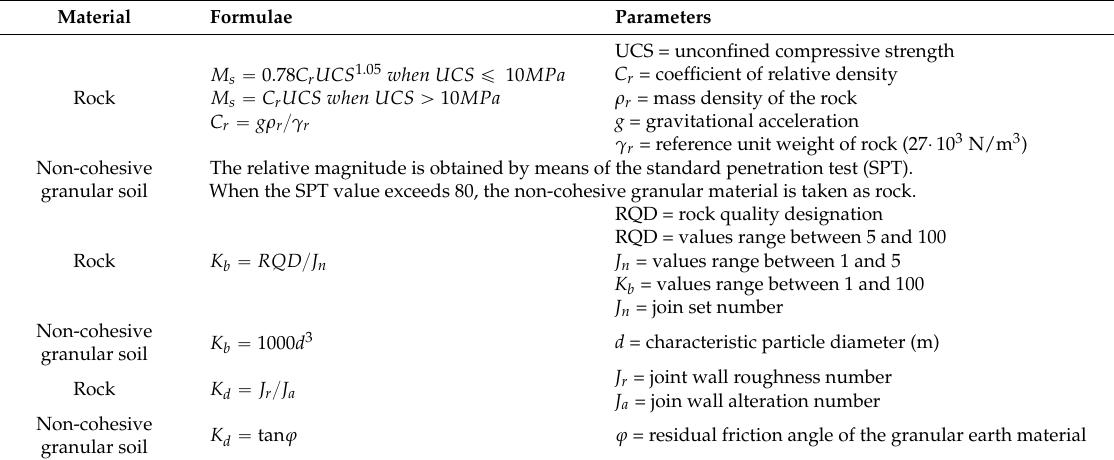
Table 4. Erodibility indexes parameters (adapted from Annandale [31]).